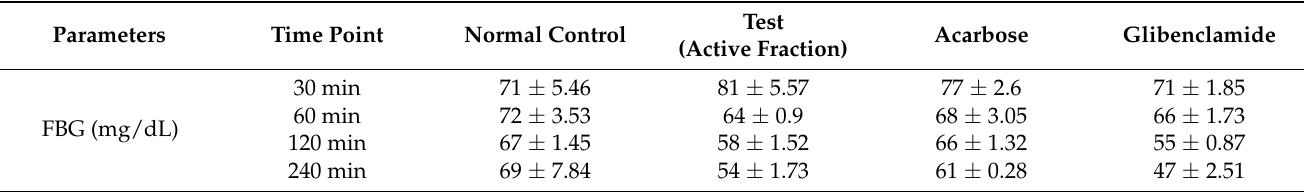
Table 3. Hypoglycemic effect of active fraction (F4) in normoglycemic rats.